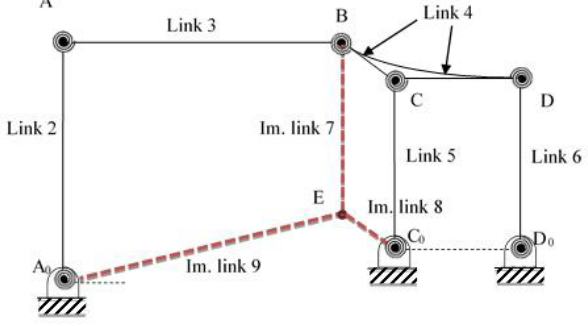
Figure 4. PRBM with an imaginary parallelogram four-bar mech- anism.